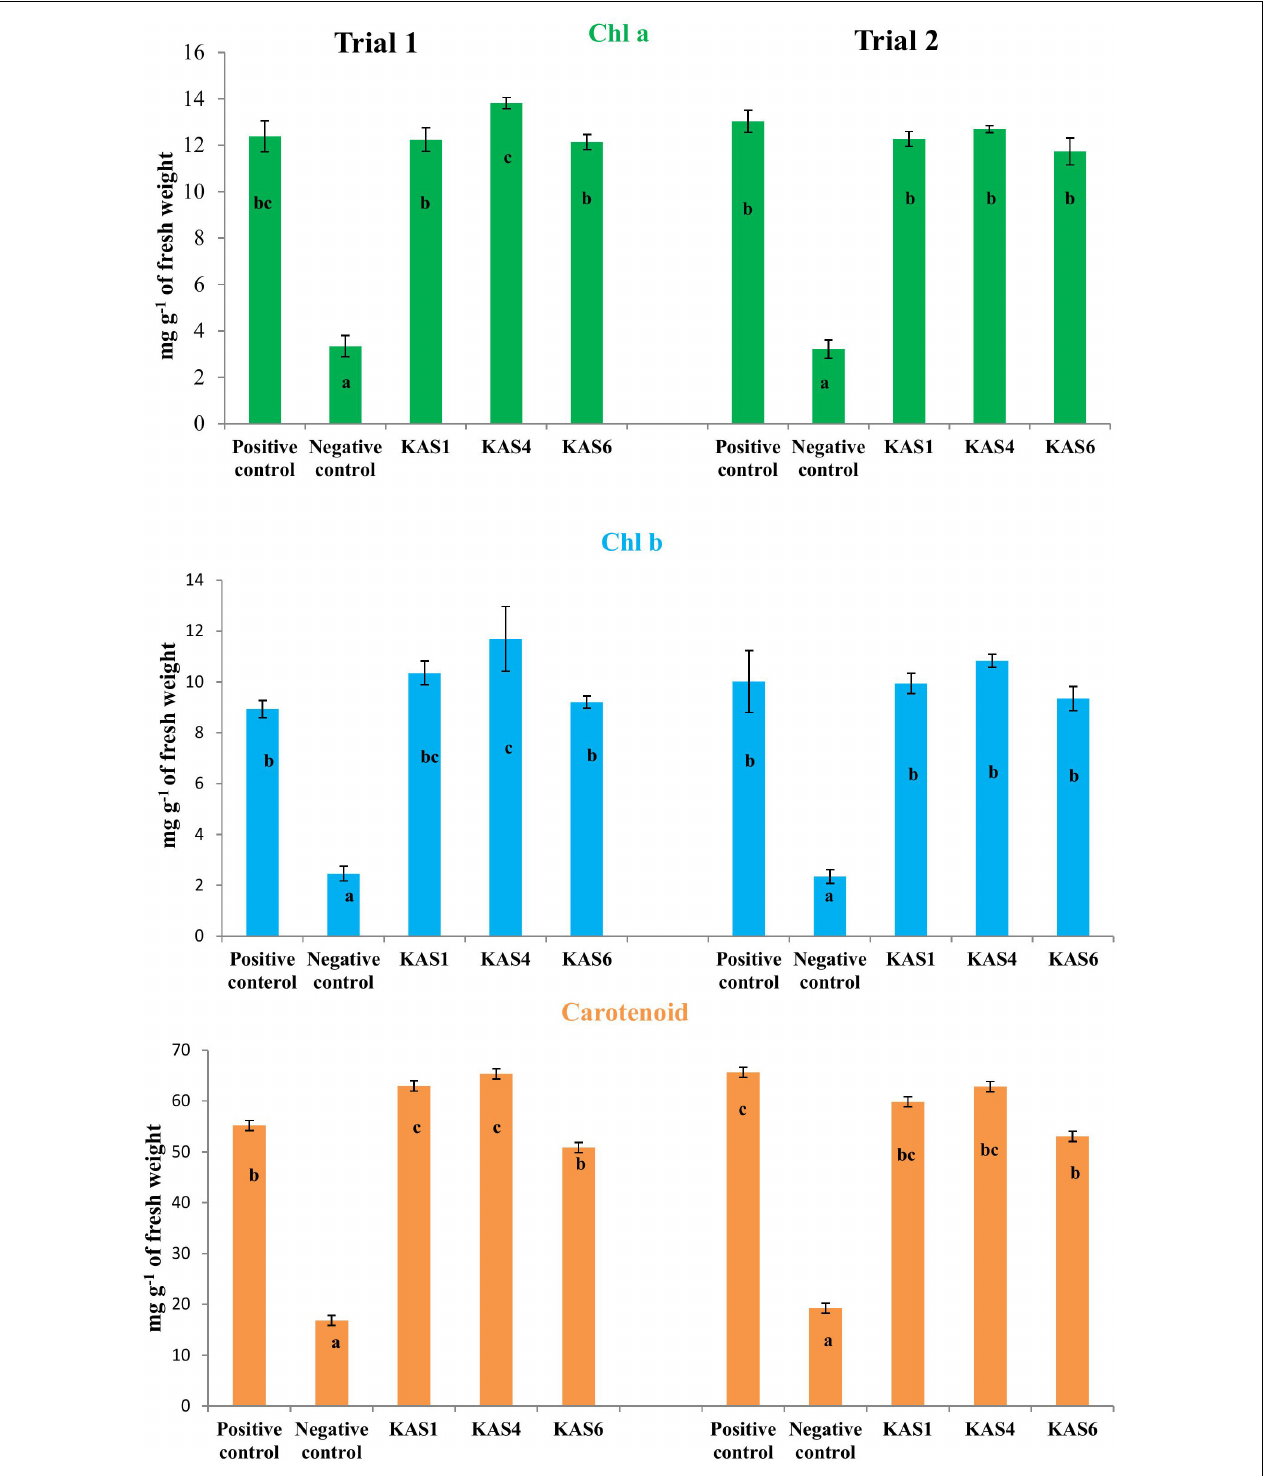
FIGURE 3 | Effect of removal and re-inoculation of SEB on the content of photosynthetic pigments of leaf tissues from 8 day old seedlings. First lane- Chlorophyll a, second lane- chlorophyll b and third lane- carotenoids. Positive control: seeds were treated only with NaOCl; negative control: seeds were treated with NaOCl + antibiotic; KAS1, KAS4, and KAS6: seeds initially treated with NaOCl + antibiotic and then inoculated with strains KAS1 ( Kosakonia cowanii ), KAS4 ( Pantoea stewartii ), and KAS6 ( Pseudomonas aeruginosa ). Different letters represent the significant differences among the means of treatments. ( P ≤ 005). Experiment was repeated in two trials ( Trial 1 and Trial 2 )